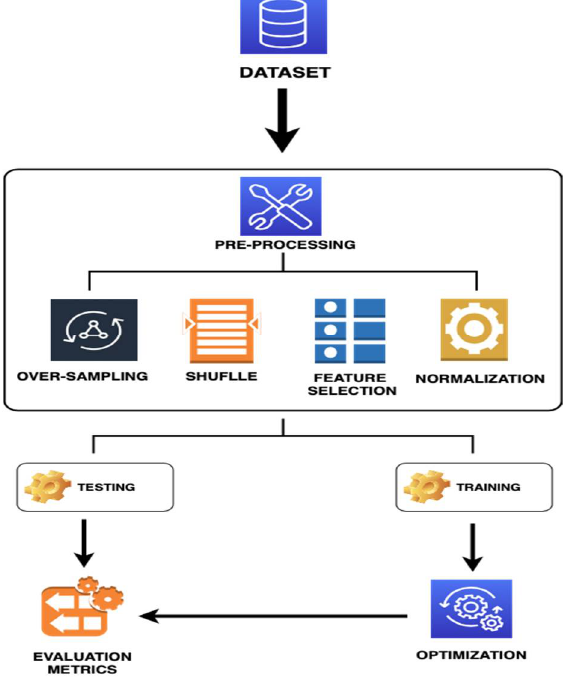
Figure 1. Flowchart of the Machine Learning for PD Prediction